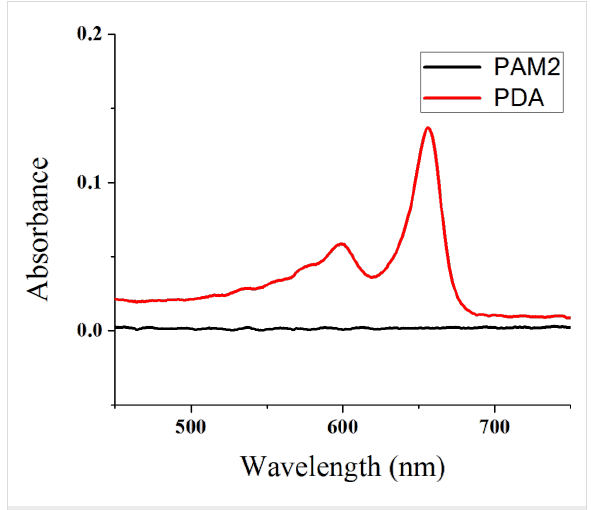
Figure 3: UV–vis spectrum of PAM2 before (black) and after (red) polymerization (PDA).